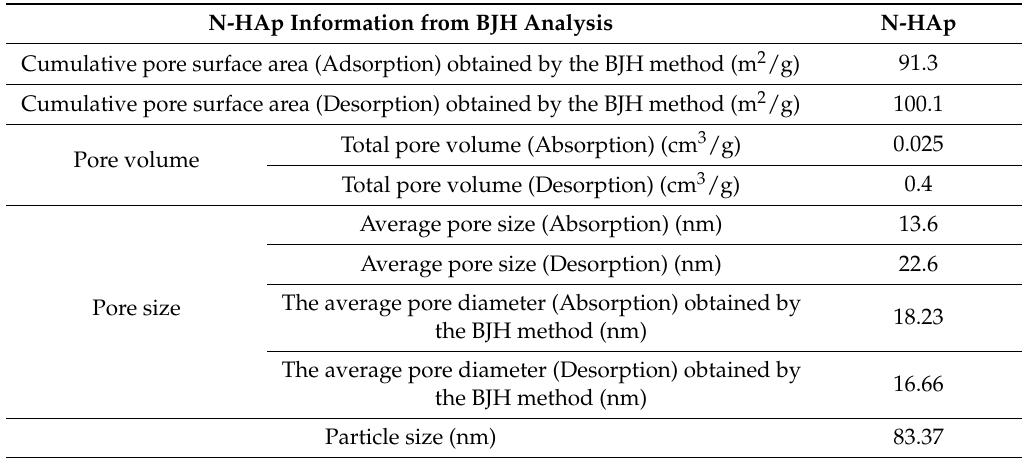
Table 1. Barrett-Joyner-Halenda (BJH) analysis results for N-Hap